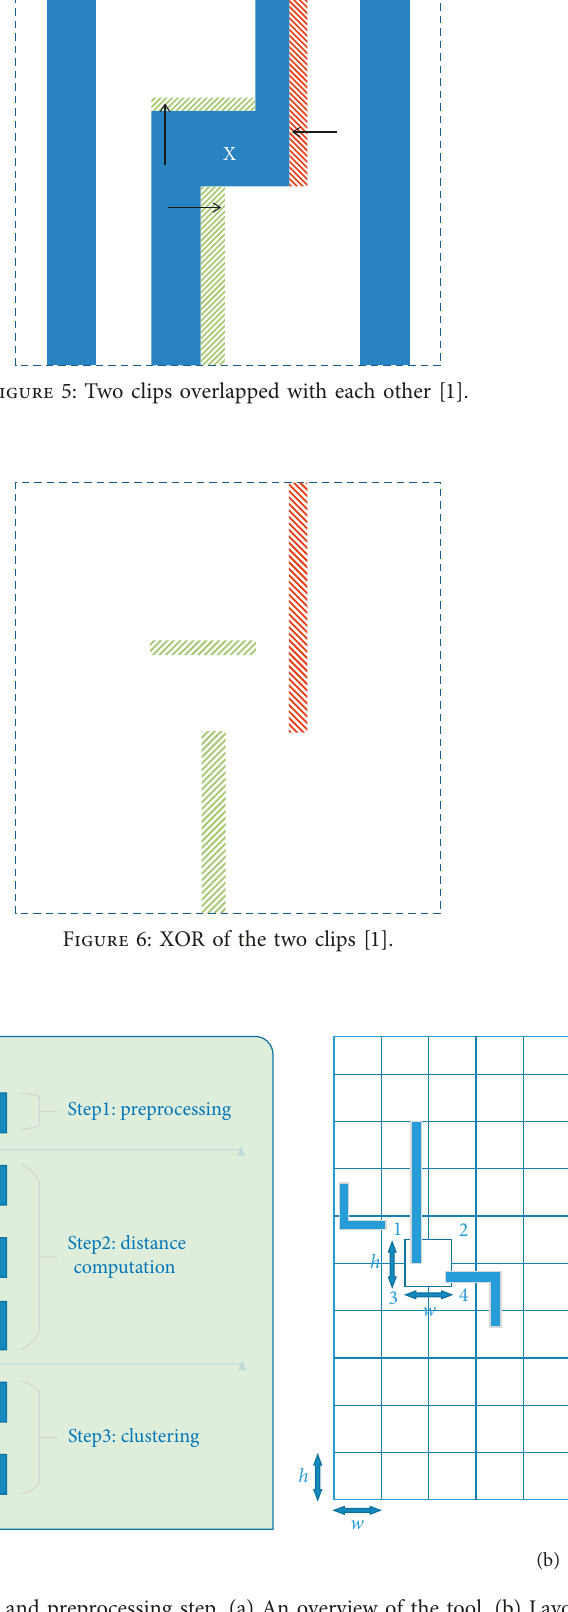
Figure 7: Overview of the tool and preprocessing step. (a) An overview of the tool. (b) Layout data processing.